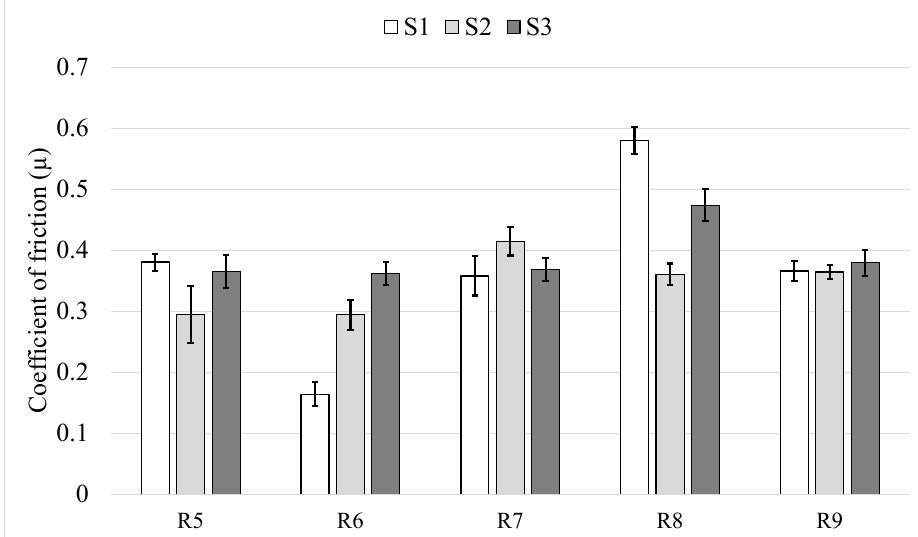
Figure 4. Average specific wear rate value of different wear track radii. Materials 2021 , 14 , x FOR PEER REVIEW